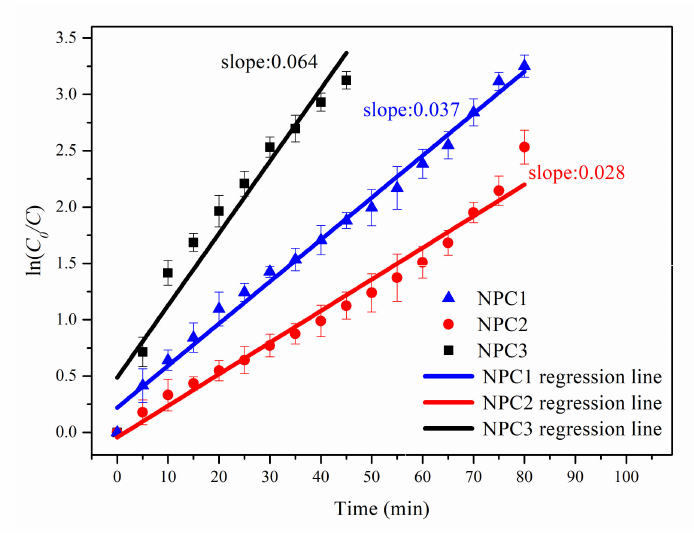
Figure 4. Regression lines of the pseudo-first-order kinetic model for three different catalysts toward the MO solution degradation process.